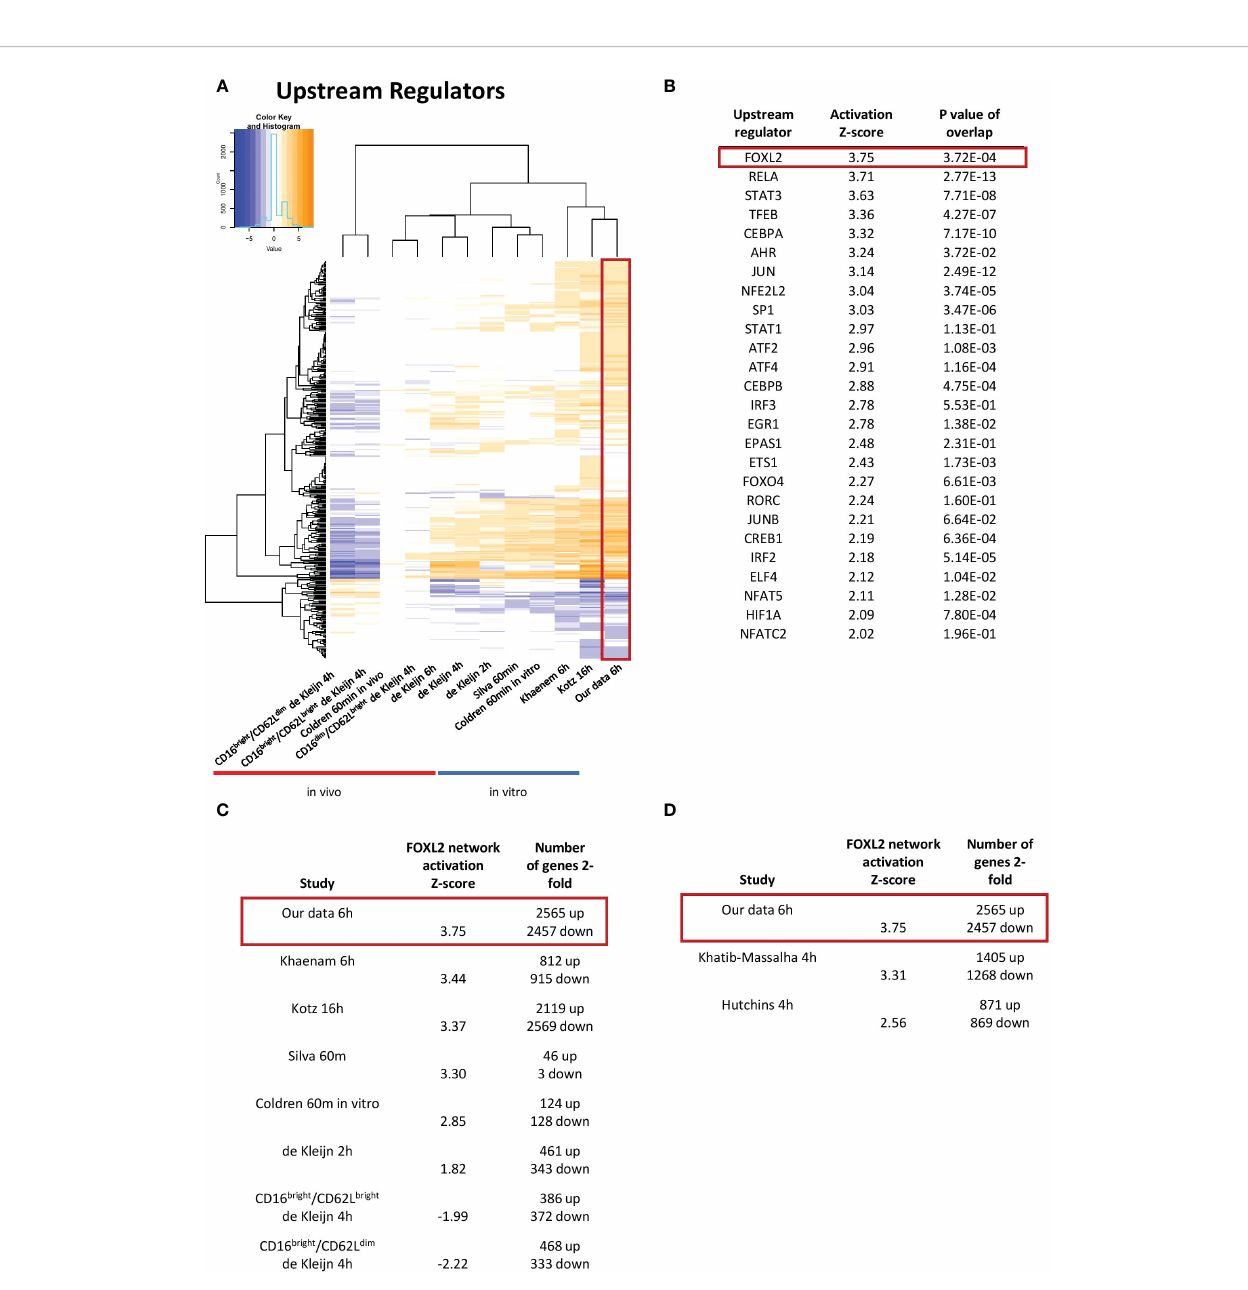
FIGURE 3 The FOXL2 transcriptional network is the most activated among transcription factor upstream regulators. (A) Enriched upstream regulators of genes in our dataset compared to other datasets from LPS-challenged neutrophils. (B) List of top activated upstream regulators that are transcription factors found in our data. FOXL2 is the most robustly enhanced transcriptional network, as indicated by the highest value for activation Z-score. The FOXL2 transcriptional network is conserved across several of the in vitro previously published human (C) and mouse (D) LPS-stimulated neutrophil studies. The number of 2-fold regulated genes for each dataset is